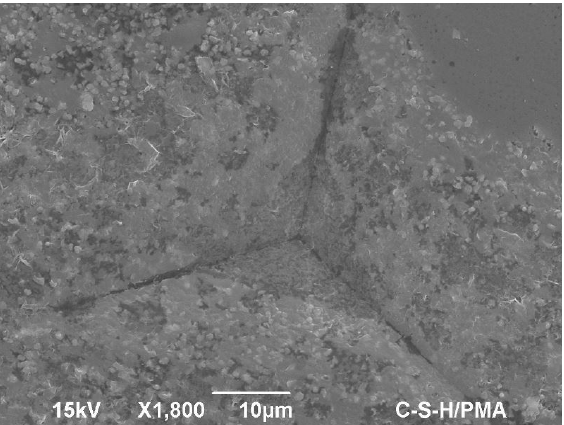
Figure 10. C-S-H/PMA SEM micrograph showing one indentation (matrix